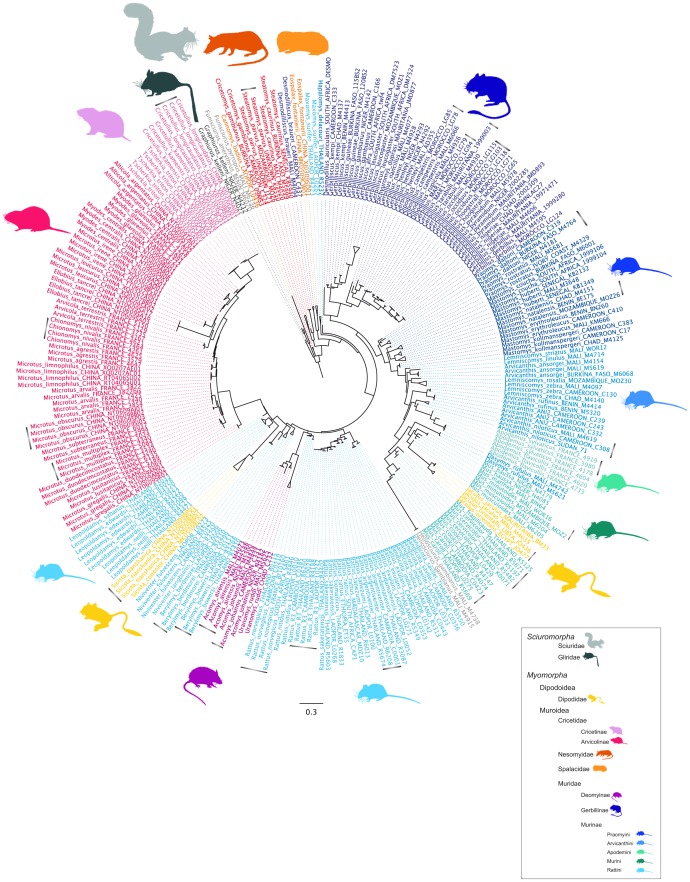
ML tree obtained from the analysis of the 136 bp mini-barcode (cytb) on the rodent reference sample (265 individuals, 103 species).Gray bars indicate terminal nodes with indicated bootstrap values (Bp) <80%.